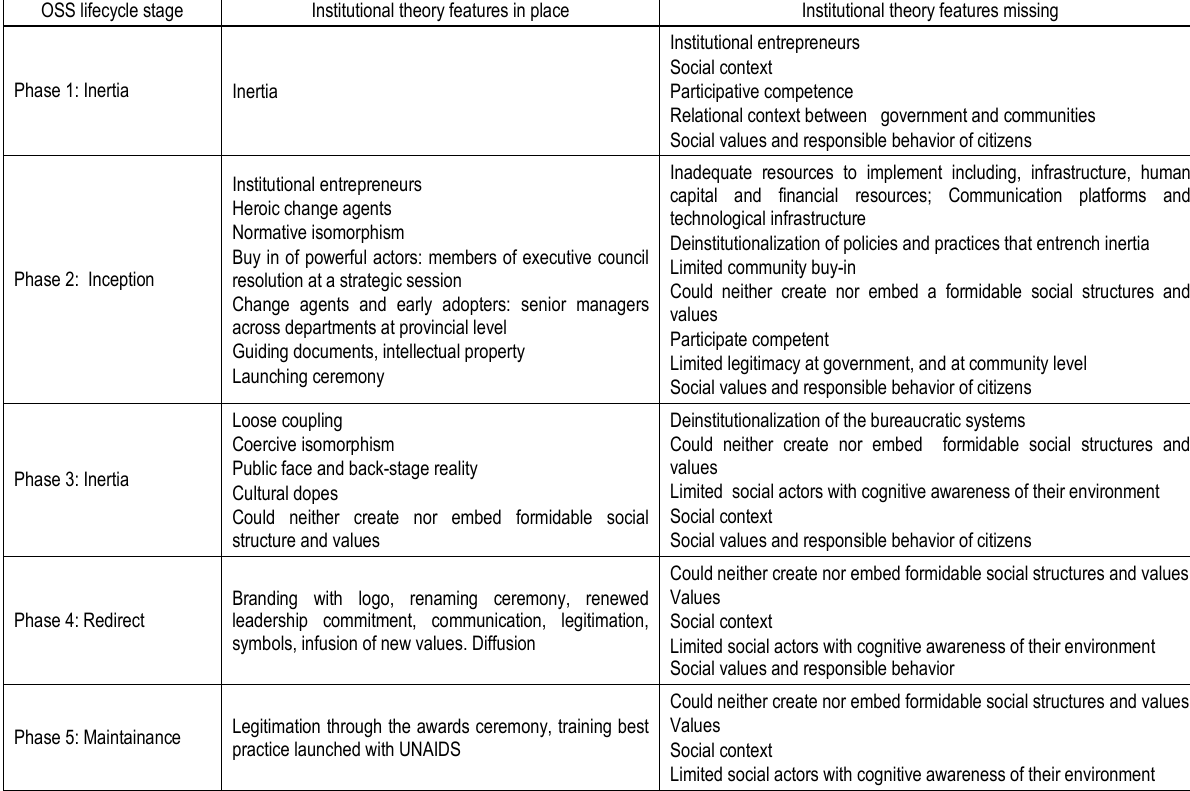
Table 1. Theorizing and operationalizing the OSS